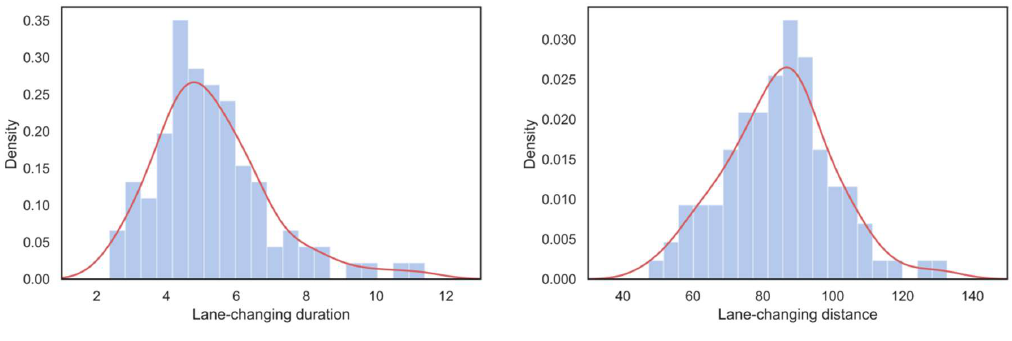
Figure 6. Duration and distance density map of lane-changing segments.